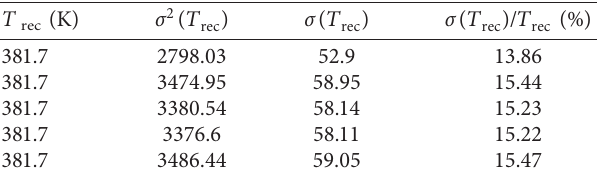
Table 9: Accuracy calculation results of the chopper wheel method at 5 °